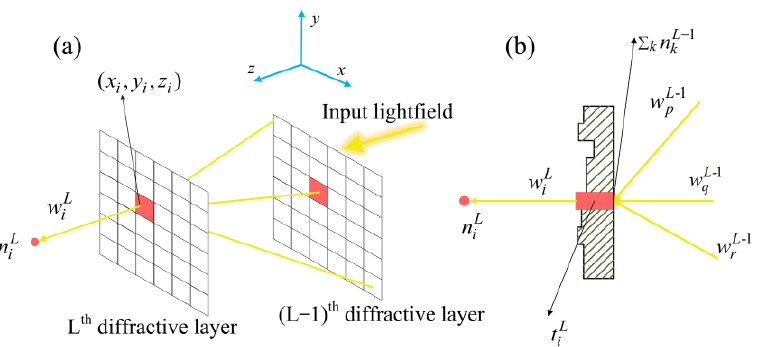
Figure 2. The illustration of forward-propagation in the D 2 NN. ( a ) General schematic of forward- propagation. ( b ) Cross-section of a neuron in the diffractive layer.